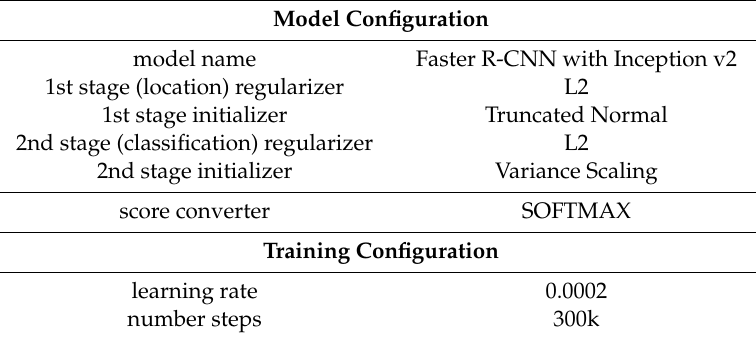
Table 3. Model and training configuration.